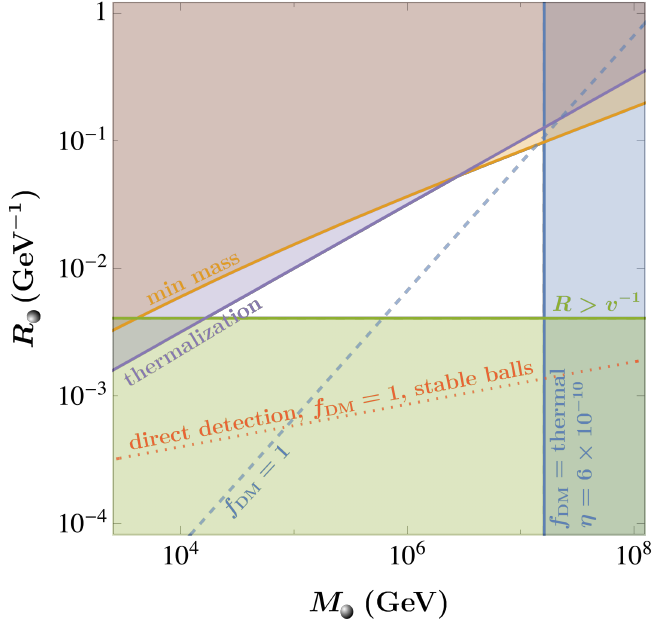
Figure 2 . Bounds on the parameter space for EWS balls to catalyze baryogenesis. Blue curves show the constraints from requiring sufficient baryogenesis to explain the observed asymmetry. The solid blue curve shows the constraint assuming the EWS ball abundance is set by annihilations and includes an enhancement factor ξ ( y ) = 10 by assuming annihilations are taking place during baryogenesis and T form = T i ; see (3.7). The dashed blue curve shows the constraint if f DM is fixed to unity, with no enhancement factor for annihilations; see (2.15). Both take T i = 100 GeV and | ∆ θ | ≤ 1 . The orange curve enforces the mass-radius relation in (3.1), while the green limits R > v − 1 from (2.7). Purple enforces that the thermalization time must be long enough according to (2.11). Finally, the red dotted line shows the direct detection limits from Xenon1T [30]. It assumes f DM = 1 , but it does not impose any constraint if the EWS balls decay after catalyzing